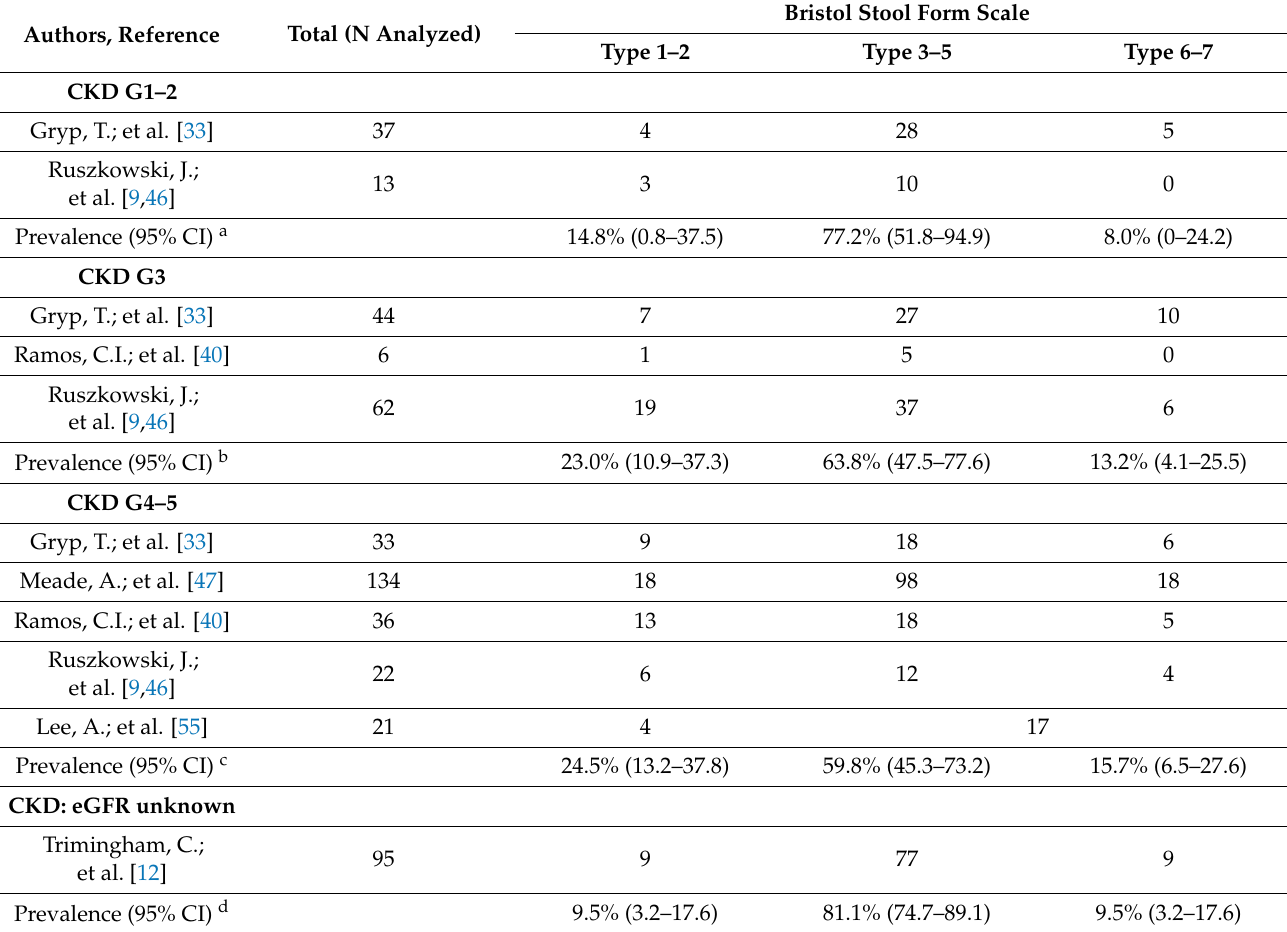
Table 2. Stool consistency in chronic kidney disease according to Bristol Stool Form